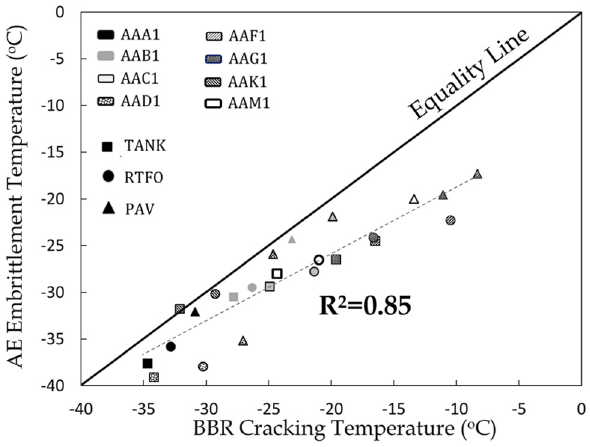
Figure 8. Correlation between AE embrittlement temperature and BBR ‐ based cracking temperature, illustrating the conservative nature of the BBR ‐ based cracking temperatures, see Table 1.